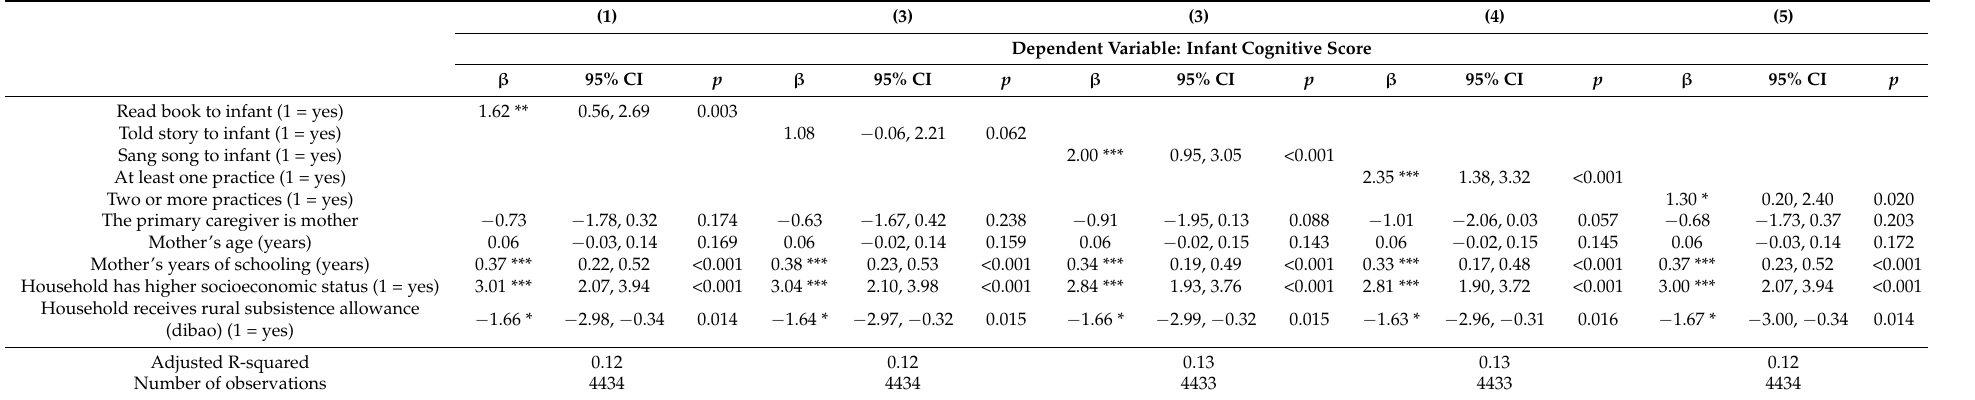
Table 4. Correlations between stimulating parenting practices and infant cognitive